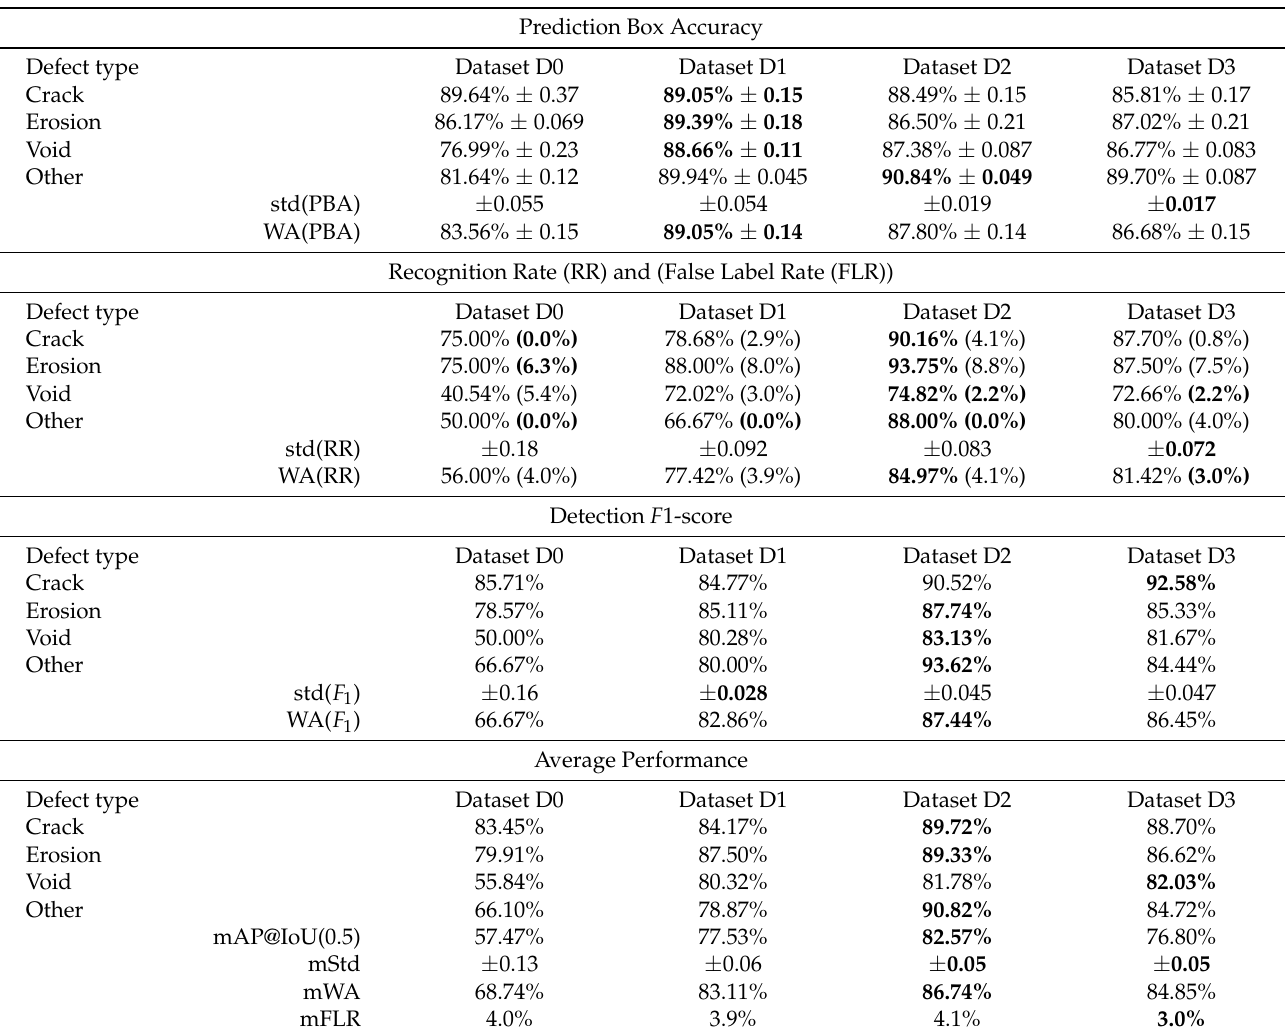
Table 7. Mask R-CNN: Performance evaluation on test dataset. WA is the weighted average as defined in (11). mWA is the mean WA of PBA, RR, and Detection F 1 -score. mStd is the mean std of PBA, RR, and Detection F 1 -score. mFLR is the weighted average of FLR across all defect